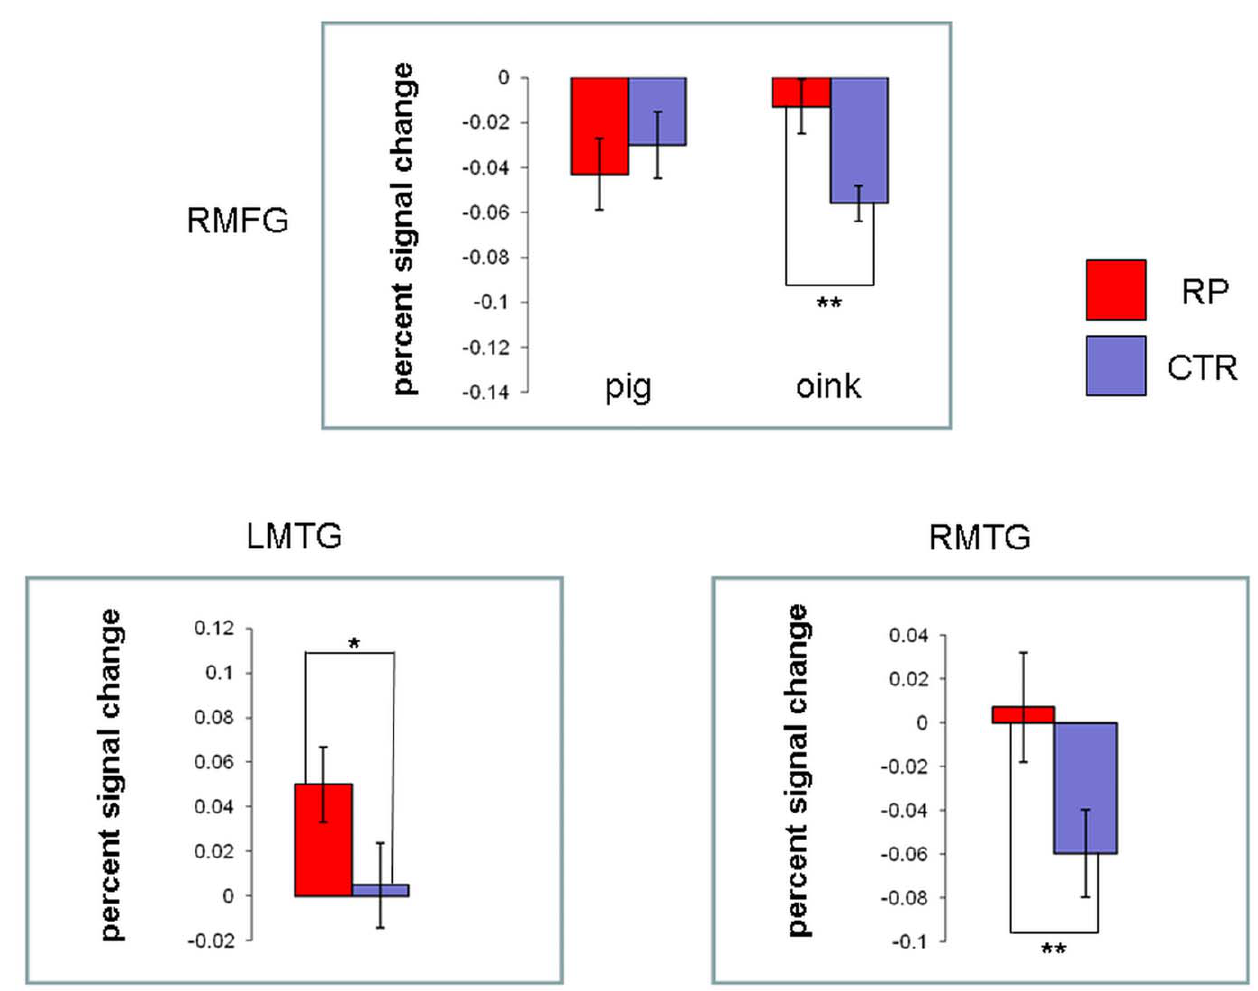
Figure 3. Responses to targets in RP and CTR within each of the ROIs. Upper panel: the Condition (RP, CTR) 6 Stimulus (oink’’, ‘‘pig’’) interaction in the right MFG. Note the different responses to ‘‘oink’’ in RP relative to CTR and the more similar activation levels for ‘‘pig’’ primes in these conditions. Lower panels: the condition effect (RP . CTR) in the left and right MTG (left and right panels, respectively). Note the deactivation in CTR in the right MTG and the positive increased activation in RP relative to CTR in the left MTG. R=right; L=left. Error bars depict the standard error. * p , 0.05; ** p , 0.01.